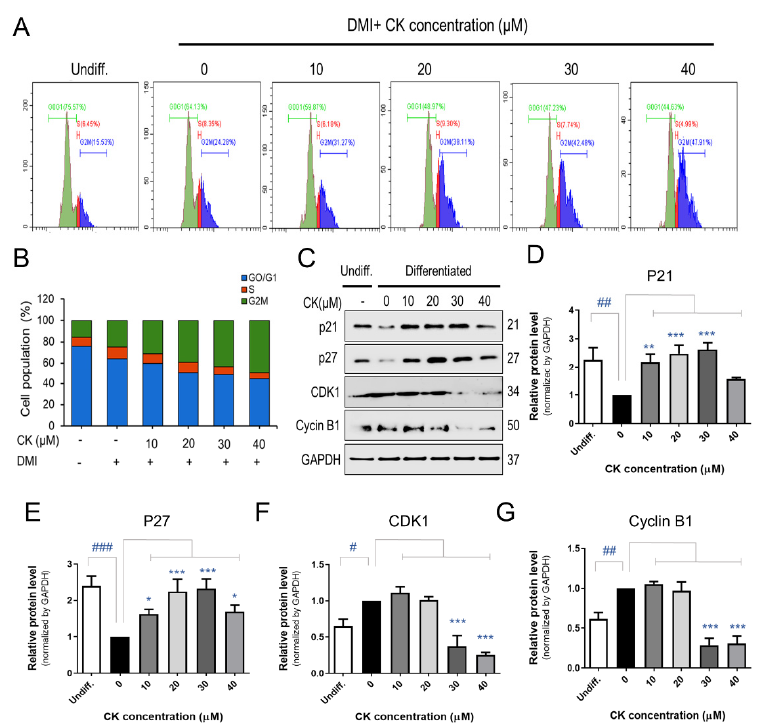
Figure 5. Effect of CK on mitotic clonal expansion (MCE) during adipogenesis in 3T3-L1 cells. ( A ) The effect of CK treatment on MCE during adipogenesis in DMI-induced pre-adipocytes was measured by performing a cell cycle analysis using flow cytometry. 3T3-L1 pre-adipocytes were treated with DMI and various concentrations of CK (10, 20, 30, 40 μ M) for 48 h. ( B ) Quantification of (A): data are presented as the average value of three repeated experiments. ( C ) The protein levels of p21, p27, CDK1, and Cyclin B1 in cells stimulated with CK (10, 20, 30, 40 μ M) for 48 h. Normalized protein levels (regarding the samples analyzed and depicted in Figure 5C) for ( D ) p21, ( E ) p27, ( F ) CDK1, and ( G ) Cyclin B1. The results are mean ± SD from three independent experiments. # : p < 0.05, ## : p < 0.01, ### : p < 0.001 compared to Undiff. group; *: p < 0.05, **: p < 0.01, ***: p < 0.001 compared to Differentiated group without CK treatment (0 μ M CK).